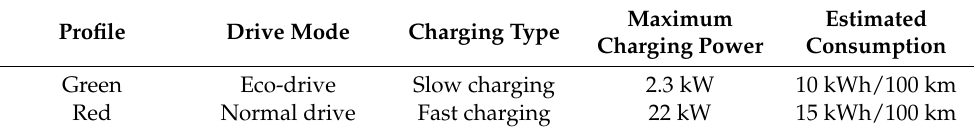
Maximum Estimated Charging Power Consumption